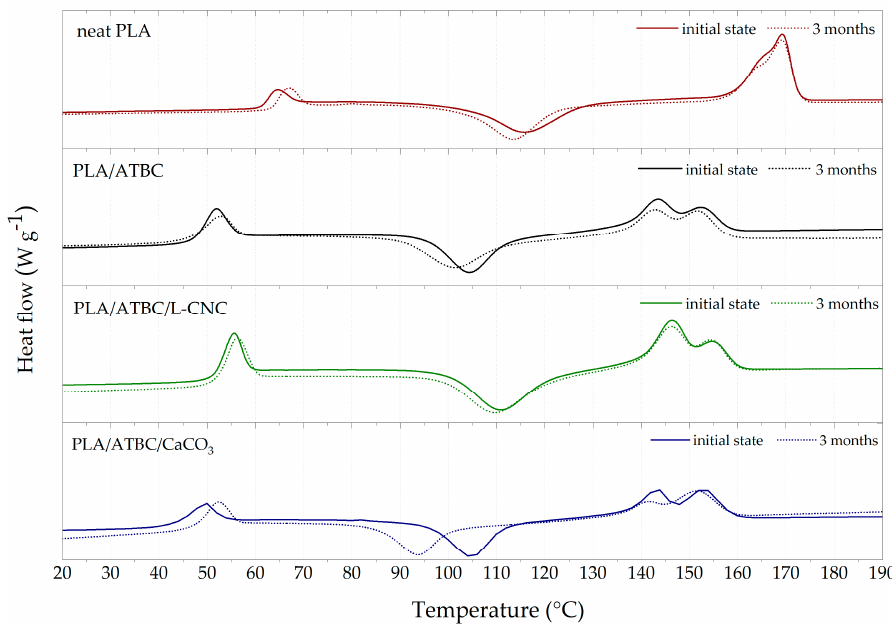
Figure 3. Thermal analysis (DSC) curves of PLA biocomposites at initial state and after three months of biodegradation in freshwater biotope. Table 5. Thermal analysis (DSC) data of PLA biocomposites exposed to 3 months of biodegradation in freshwater biotope.